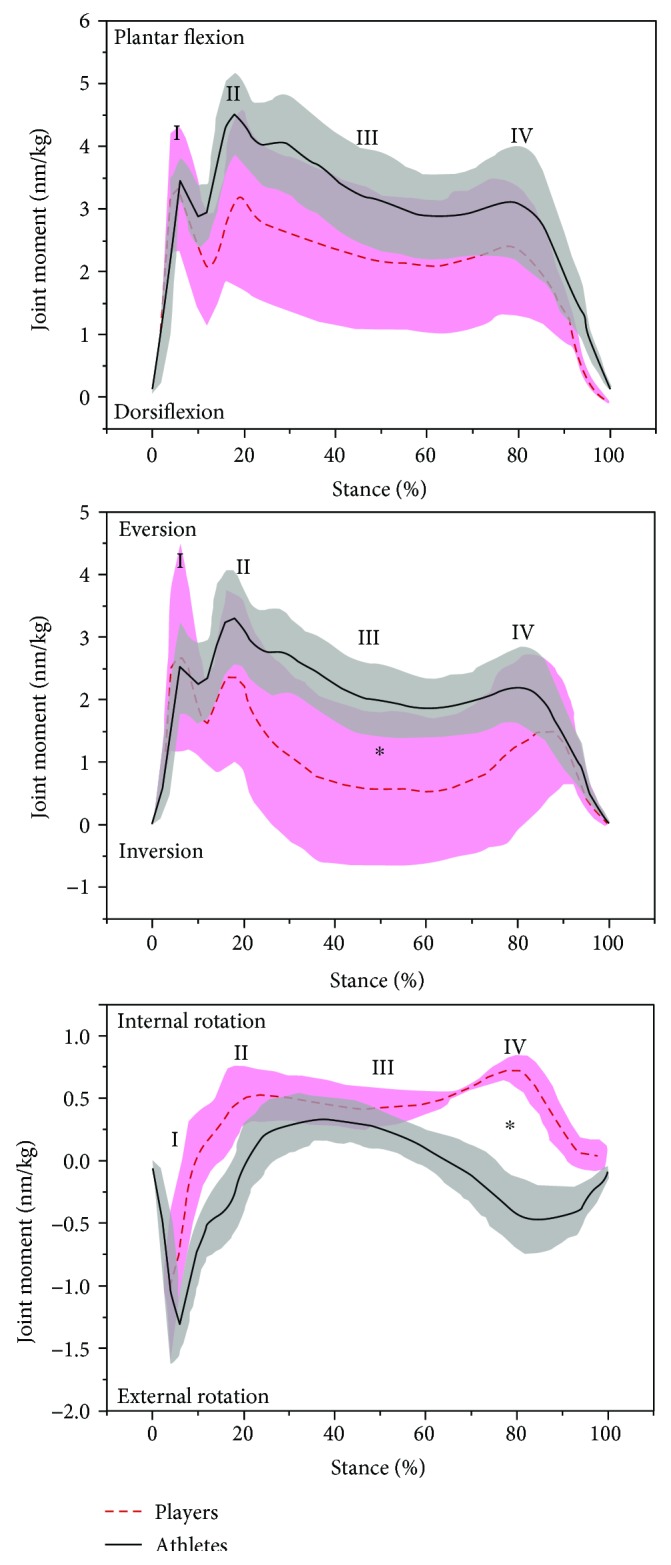
The mean (standard deviation—shadow with bars) value of ankle joint moment in the sagittal (plantar flexion/dorsiflexion), frontal (eversion/inversion), and horizontal (internal/external rotation) planes between professional and amateur badminton players (∗ indicates significance level p < 0.05).